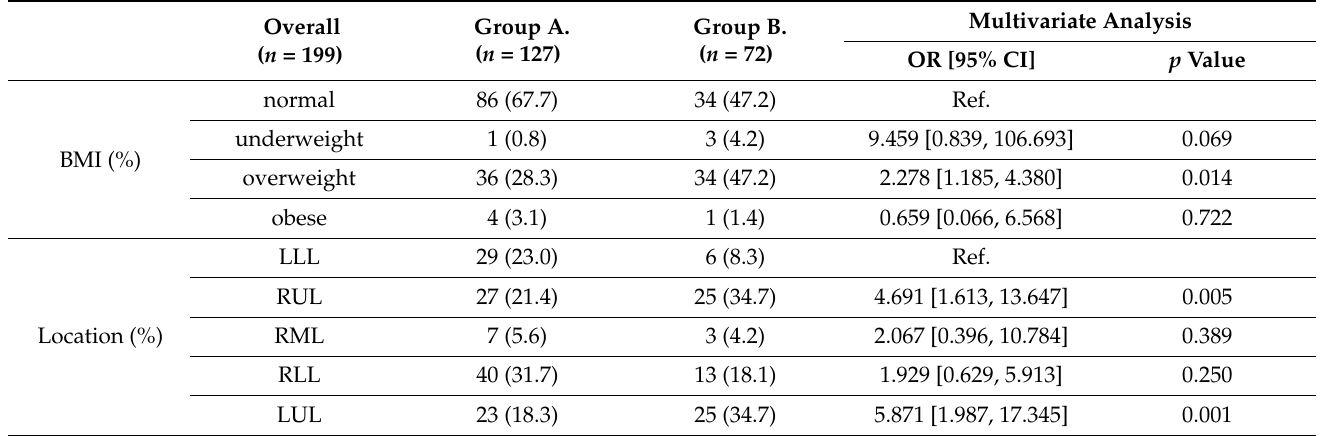
Table 4. Perioperative factors with statistical significance between group A and group B by multivari- ate